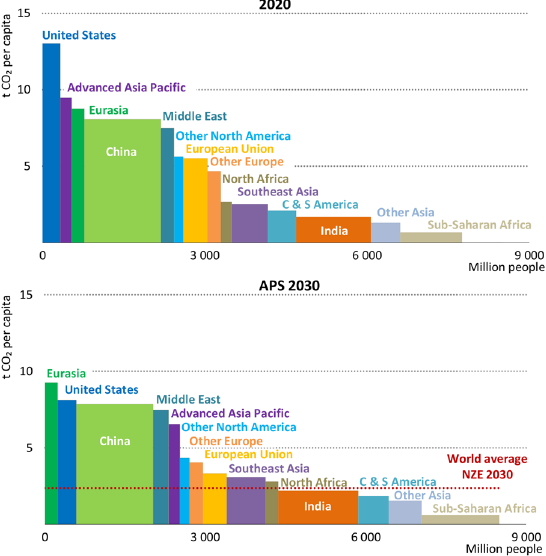
Figure 2. Regional trends in per capita CO2 emissions in 2020 and 2030 of the APS [2].